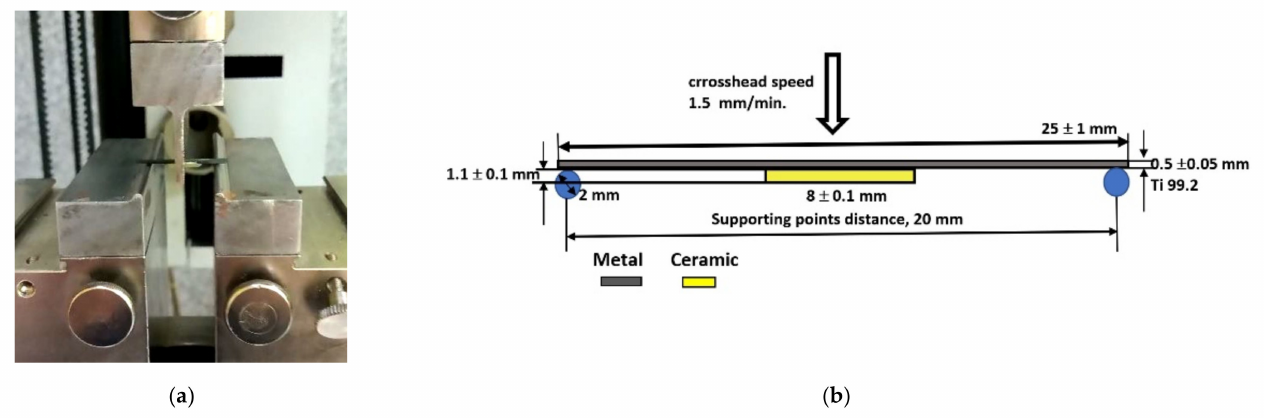
Figure 2. Mechanical testing of Duceratin Kiss porcelain samples ( a ) view of the samples arrangement in the bending system supports, ( b ) schematic view of the three-point bending test of a metal-ceramic system according to EN ISO 9693:2019